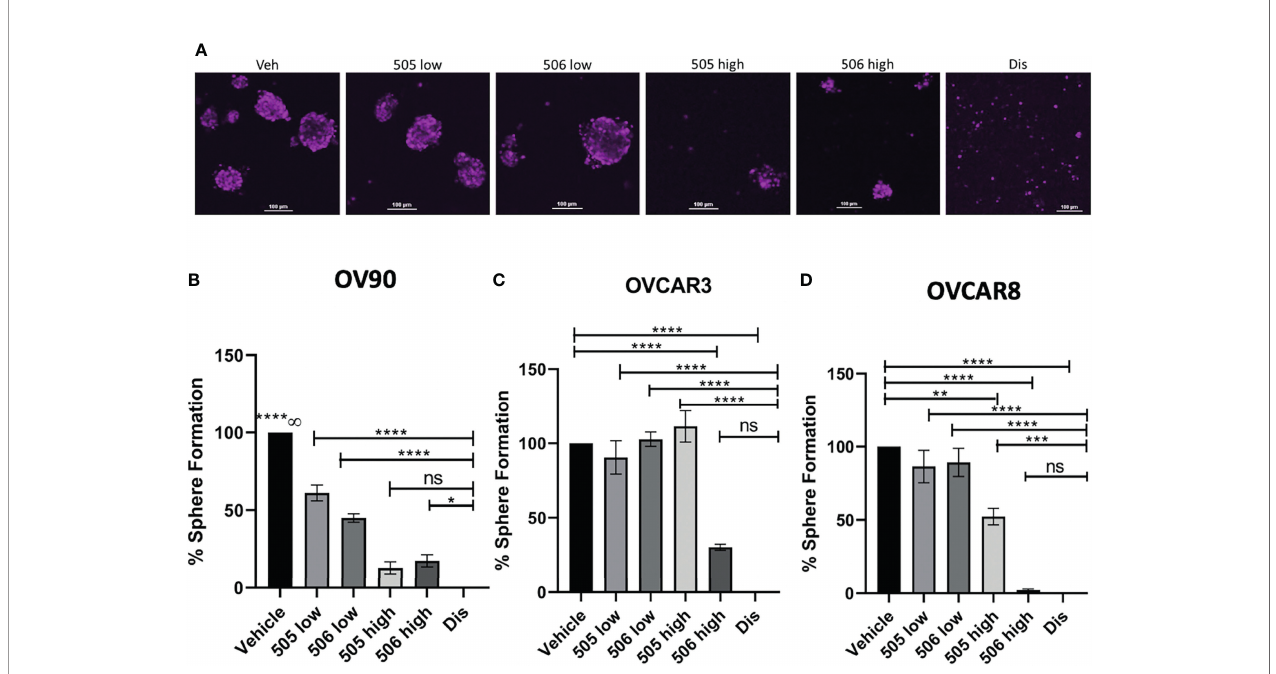
FIGURE 4 | ALDH inhibitor activity on EOC cell sphere formation. (A) Representative images of DRAQ5 stained spheres formed by OV90 cells at day 7 after indicated treatments. Scale bar is 100 µm. (B) OV90, (C) OVCAR3 and (D) OVCAR8 cells were plated in TEM in ULA plates at 2,000 cells/well in the presence of the indicated drugs or vehicle (0.1% DMSO). 505 low dose = 2 m M, 505 high dose = 20 m M, 506 low dose = 45 m M, 506 high dose = 100 m M, disul fi ram = 250 nM. The cells were maintained in TEM for 7 days, media and drugs were replenished every 48 H and on day 7 images were acquired of spheroids for quanti fi cation of number of spheroids measuring >1,000µm 2 . Graphs represent mean and SEM of each treatment, from 3 independent experiments, ns, not signi fi cant; ∞ , compared to all groups, *p < 0.05, **p < 0.01, ***p < 0.001, ****p < 0.0001, compared to vehicle